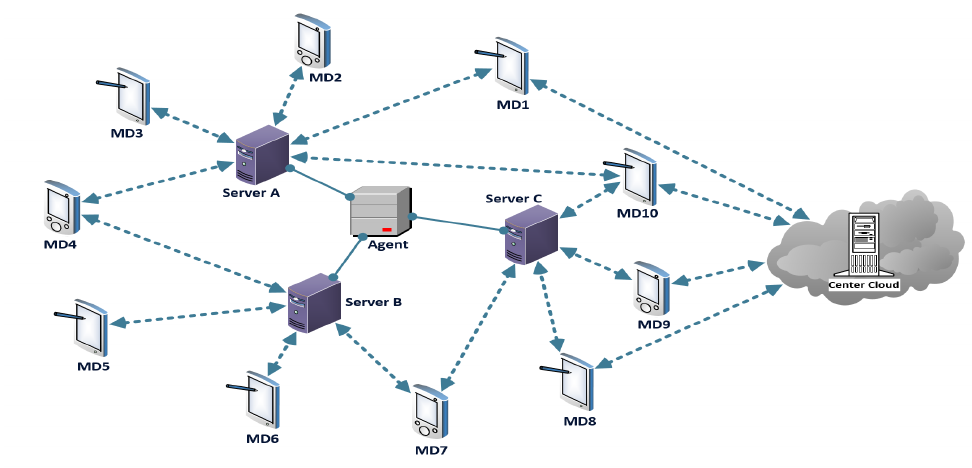
Figure 1. The discussed system model